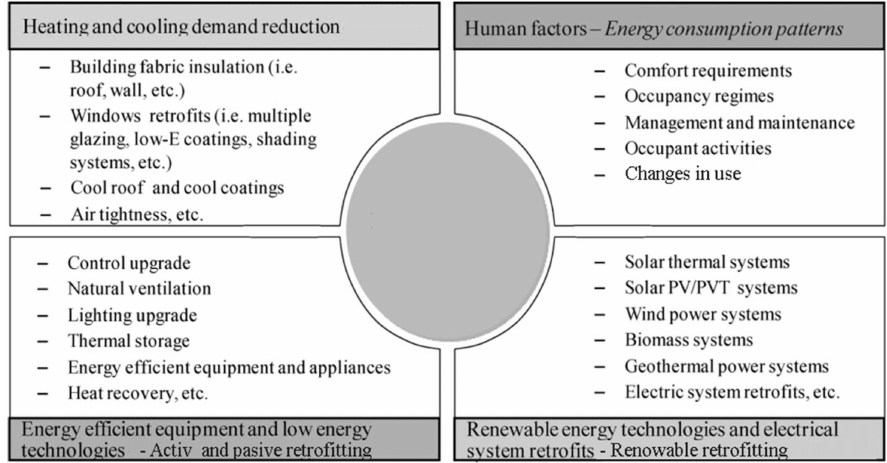
Figure 2. Main categories of building retrofit technologies